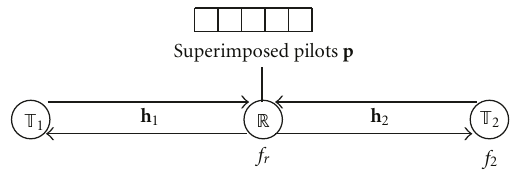
Figure 1: System configuration for two-way relay